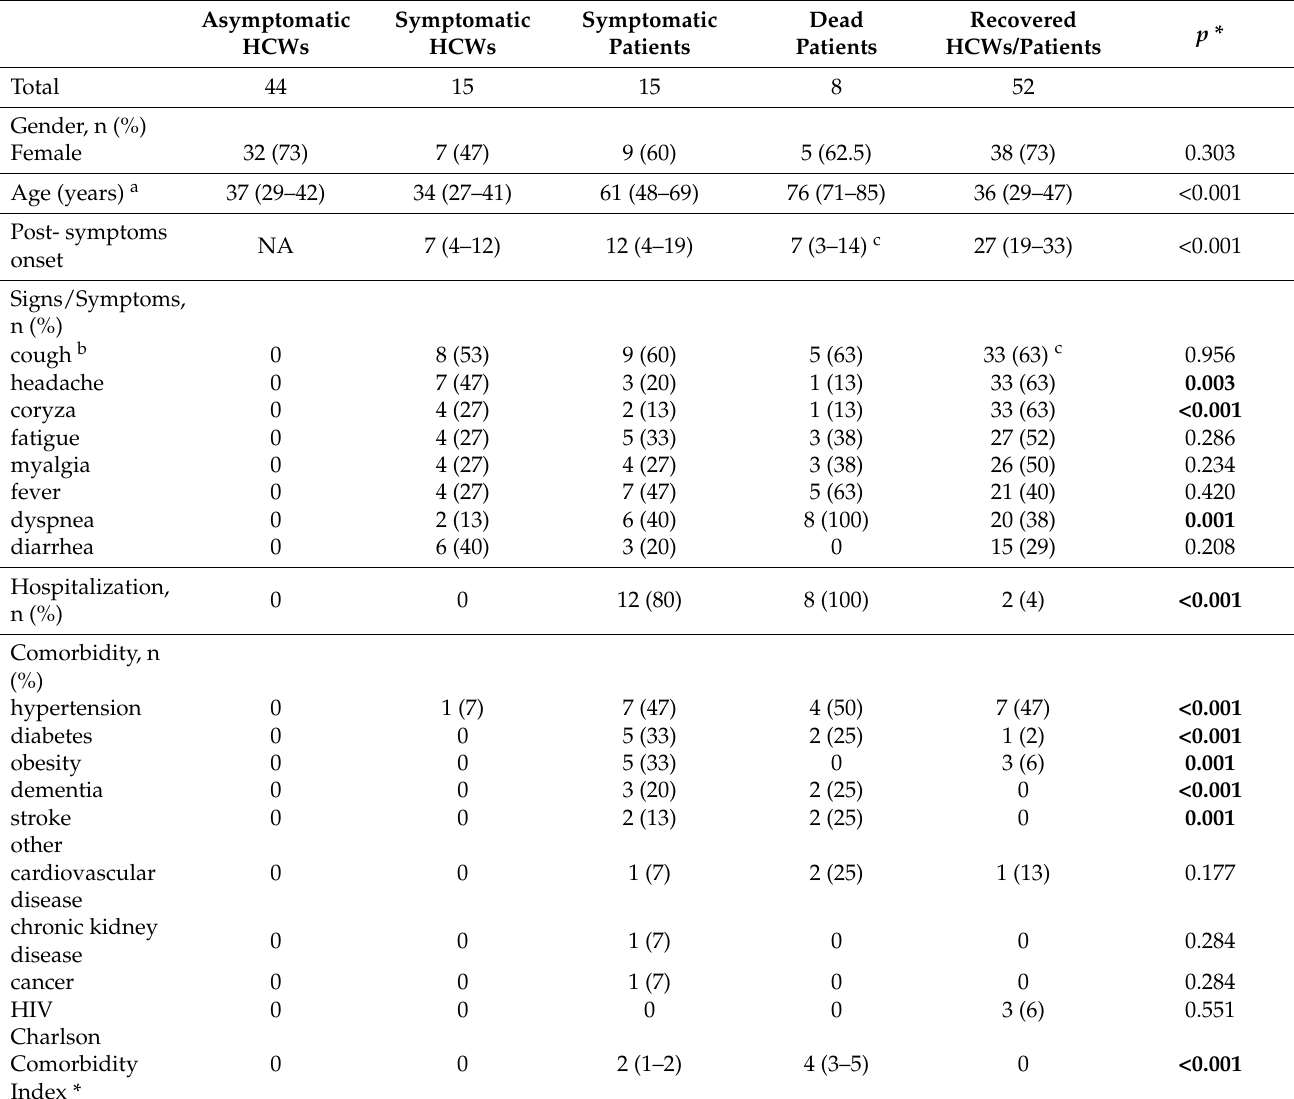
Table 1. Demographic and clinical characteristics of Health care workers (HCWs) and COVID-19